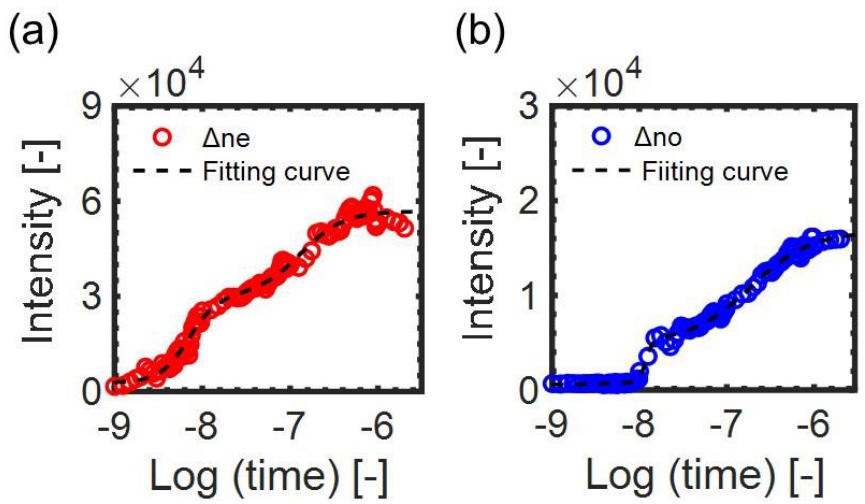
Figure 4. The examples of the fitting curves for ( a ) ∆ n e ( t ) and ( b ) ∆ n o ( t ) responses by a model function of Equation (4): the response curves for the pump intensity 4.22 mJ/pulse are shown. The fitting parameters were ( a ) y 0 = 3.81 × 10 3 , y 1 = 3.02 × 10 4 , y 2 = 2.66 × 10 4 , log t half,1 = − 8.15, log t half,2 = − 6.88 and ( b ) y 0 = 6.32 × 10 2 , y 1 = 5.62 × 10 3 , y 2 = 9.90 × 10 3 , log t half,1 = − 7.92, log t half,2 = − 6.78 .